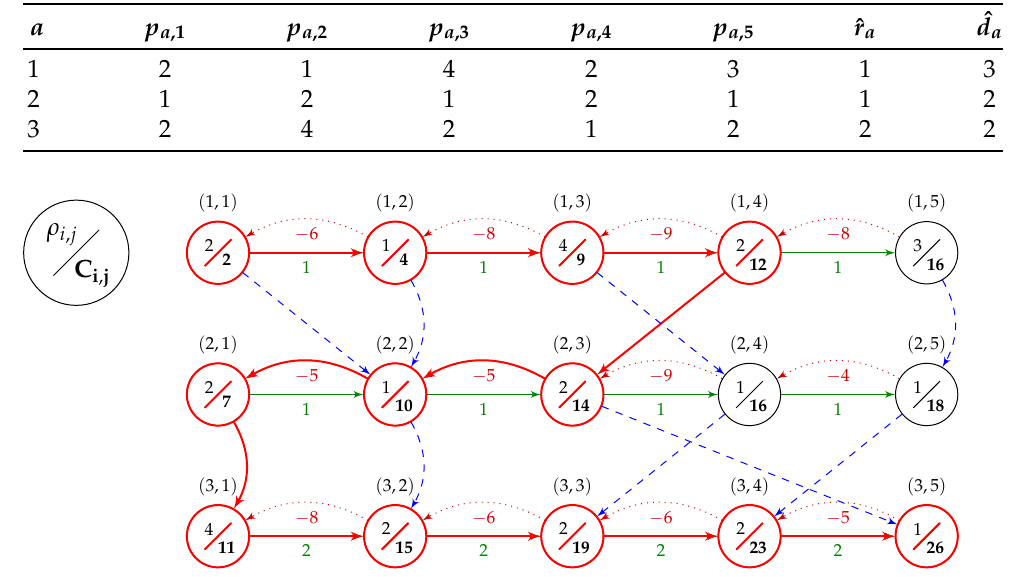
Table 2. Problem instance from Example 2 for n = 5 and m = 3.